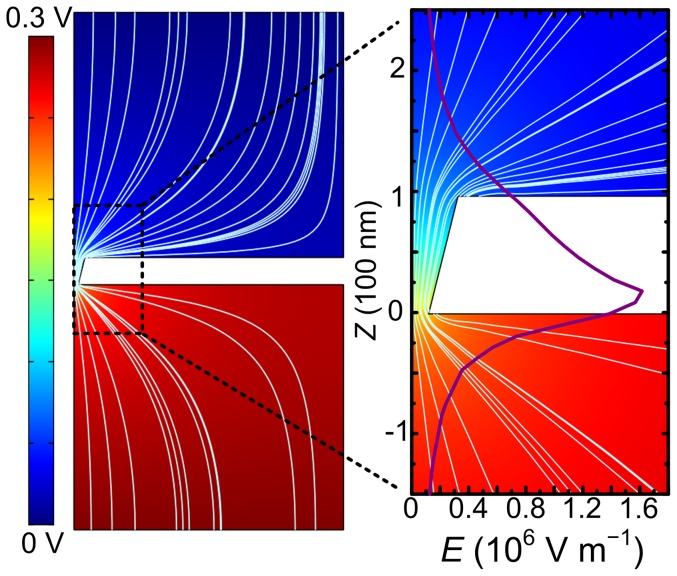
Simulation of the electric potential and field distributions of the nanopore in two dimensions.Left: Color coded potential distribution and electric field lines (white) of the 100 nm thick conical nanopore for a applied voltage of 300 mV. Right: A close-up view of the black rectangle area, integrated with the electric field strength () along the center (axis Z) of the pore, where the Z at the tip side of pore is set as 0. A asymmetric electric field is formed due to the conical shape of the pore, where the electric field strength () is higher at the tip side than the base side.